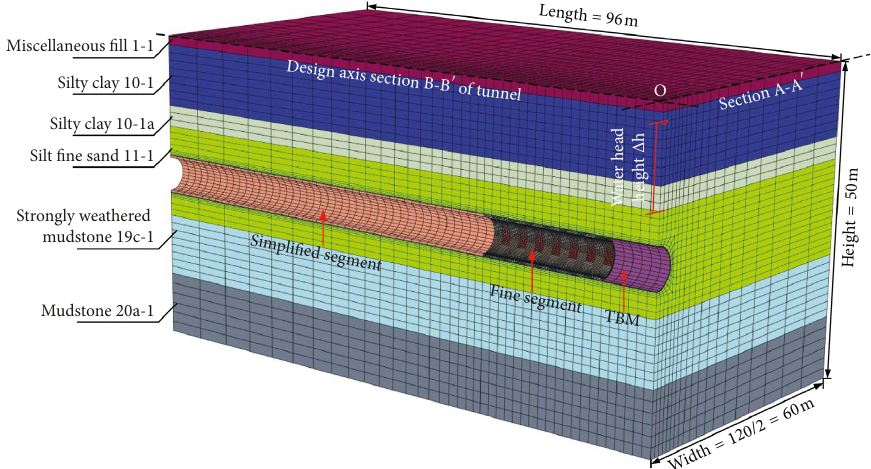
Figure 6: Simulated model of the launching-arrival stage of shield tunneling in the XW